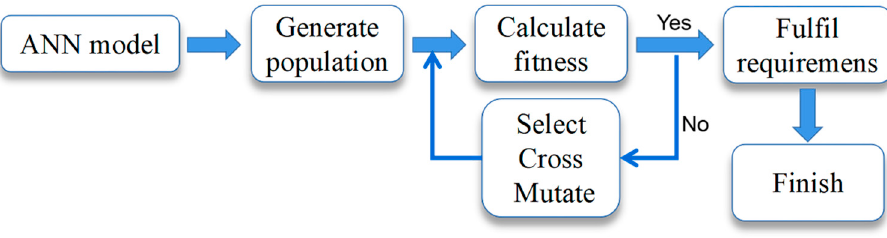
Figure 1. Genetic algorithm process.